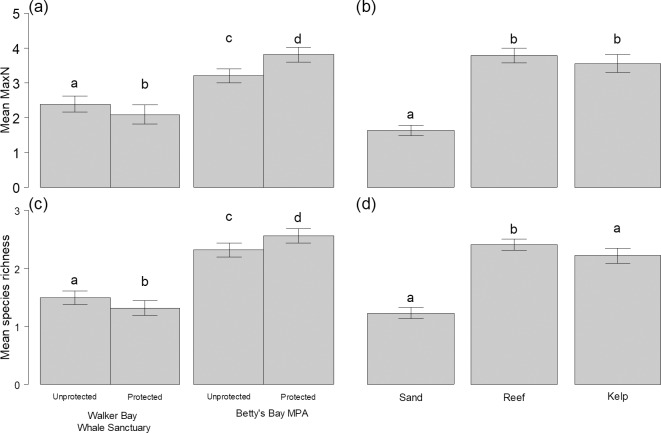
Mean chondrichthyan relative abundance and richness by protection and habitat.(a, b) Mean summed MaxN per BRUV and (c,d) mean species richness per BRUV, compared across: (a, c) protection level in each region and (b, d) habitat type. Bars are +/- SE. Comparisons with the same letter were not significantly different.